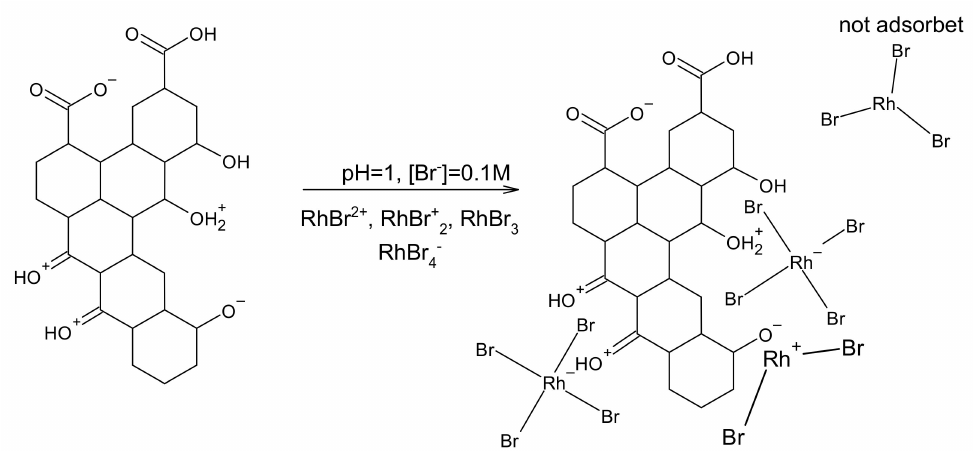
Figure 17. Graphical presentation of the interaction between Rh(III) bromide complexe ions with oxygen-containing functional groups.